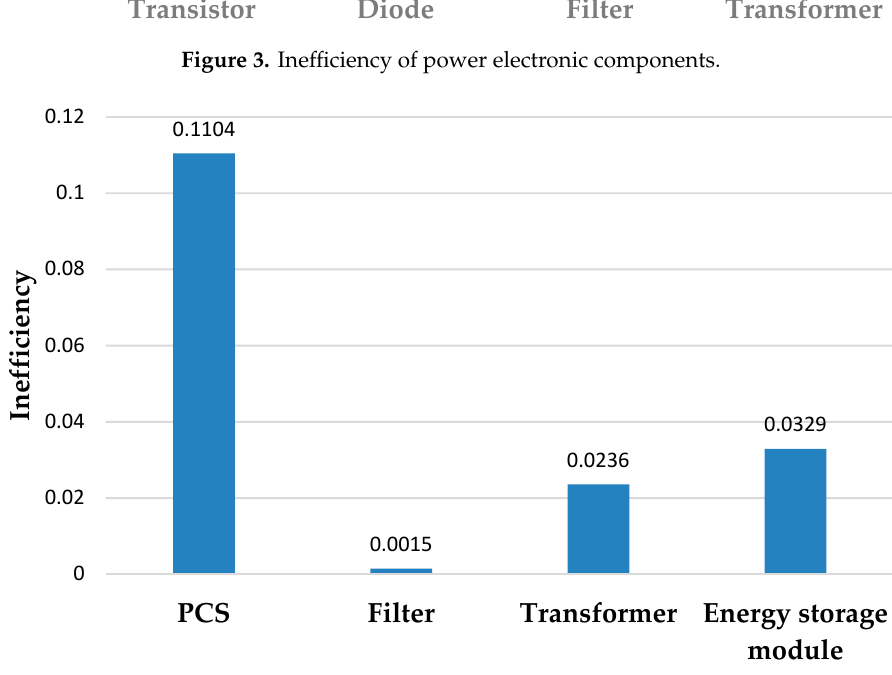
Figure 4. Ine ffi ciency of the cell storage Figure 4 . Inefficiency of the cell storage system. Figure 4 . Inefficiency of the cell storage system.